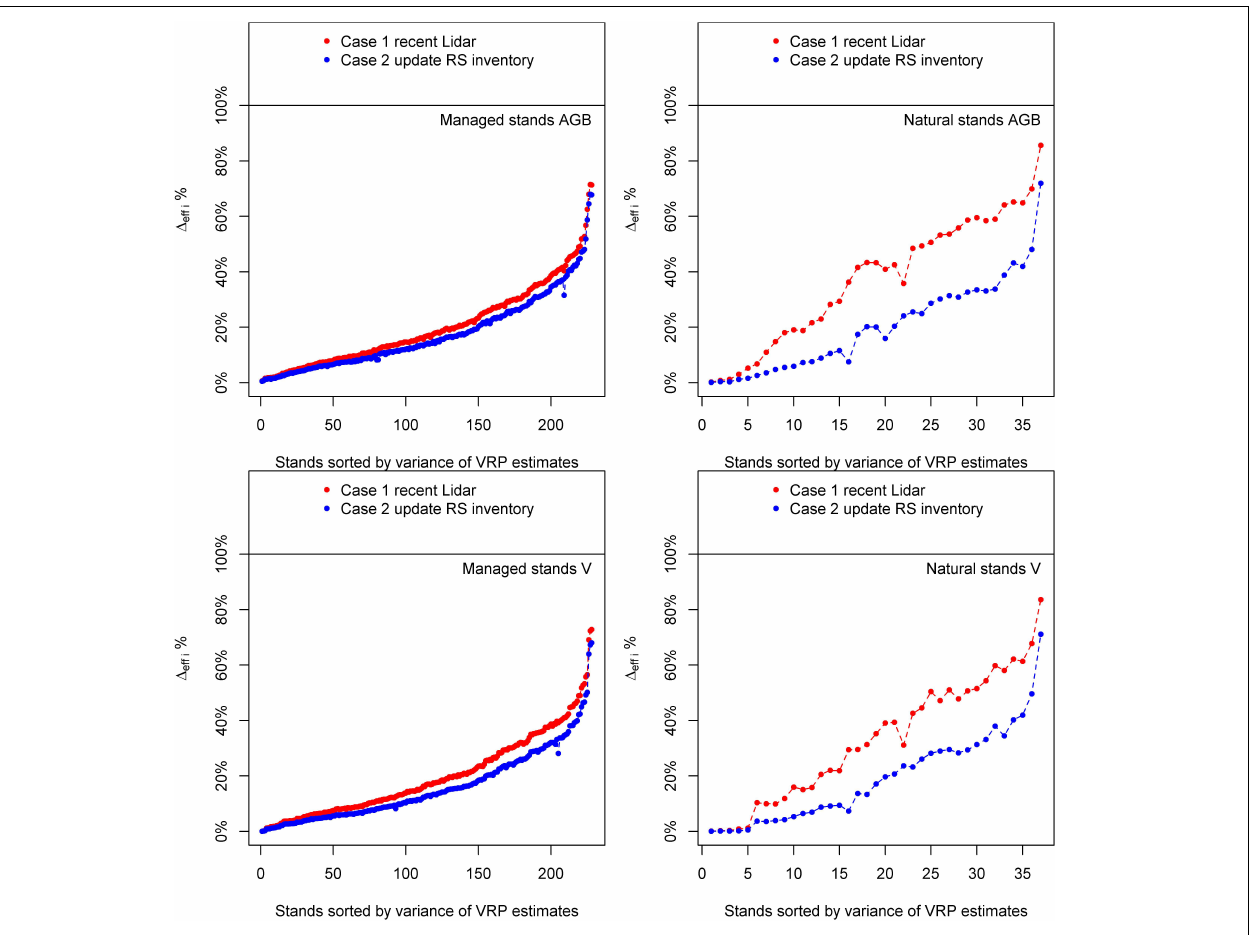
FIGURE 6 | Reduction of uncertainty achieved by Fay–Herriot models with respect to an inventory based only on ground data( (cid:52) e ff i ) for Case 1 and Case 2 for above-ground biomass (AGB) and volume (V).